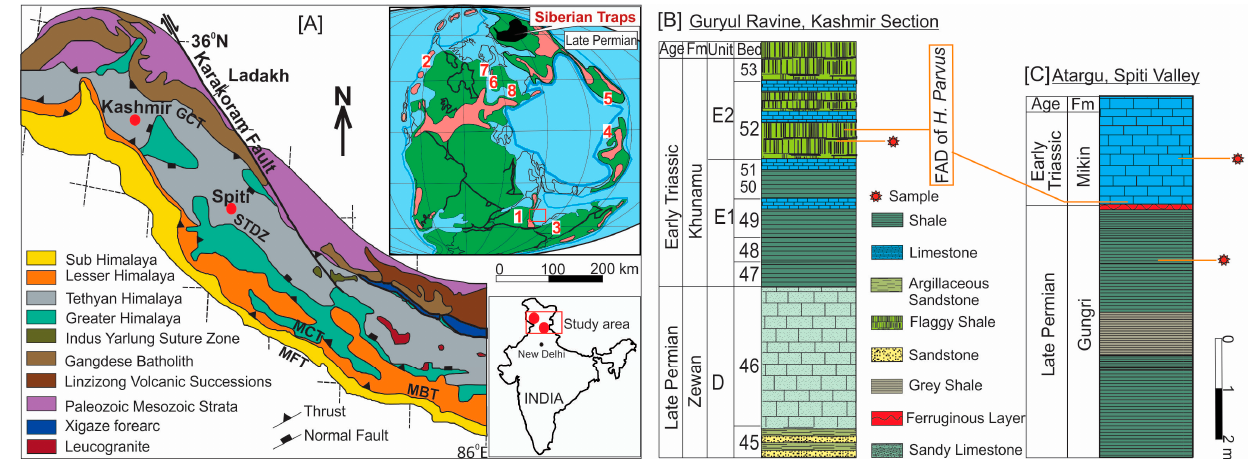
Figure 1. ( A ) Geological map showing sample location from the Himalaya, India. Simplified stratigraphic detail of ( B ) Guryul Ravine and ( C ) Spiti valley sections are also included. Figure modified from [20,37]. The Paleo ‐ geographic map is modified from [38].